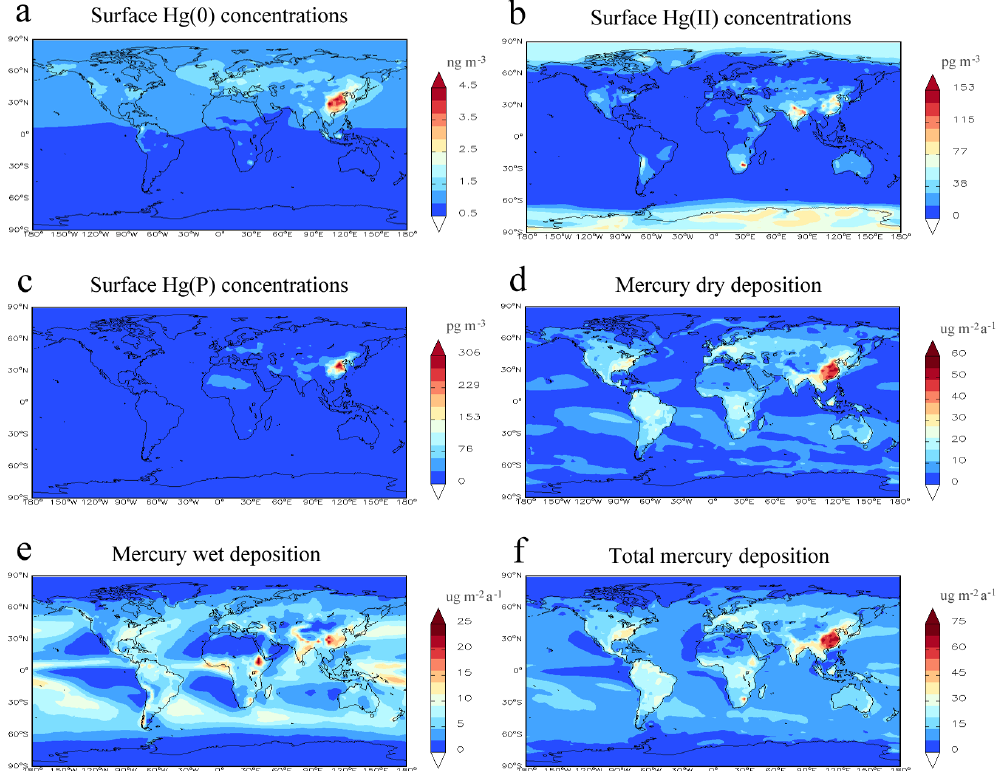
Figure 4. Global spatial distributions of annual average SMC and mercury deposition: (a) surface Hg(0) concentrations; (b) surface Hg(II) concentrations; (c) surface Hg(P) concentrations; (d) mercury dry deposition (Hg(0) dry deposition + Hg(II) dry deposition + Hg(P) dry deposition); (e) mercury wet deposition (Hg(II) wet deposition + Hg(P) wet deposition); (f) total mercury deposition (dry deposition + wet deposition).